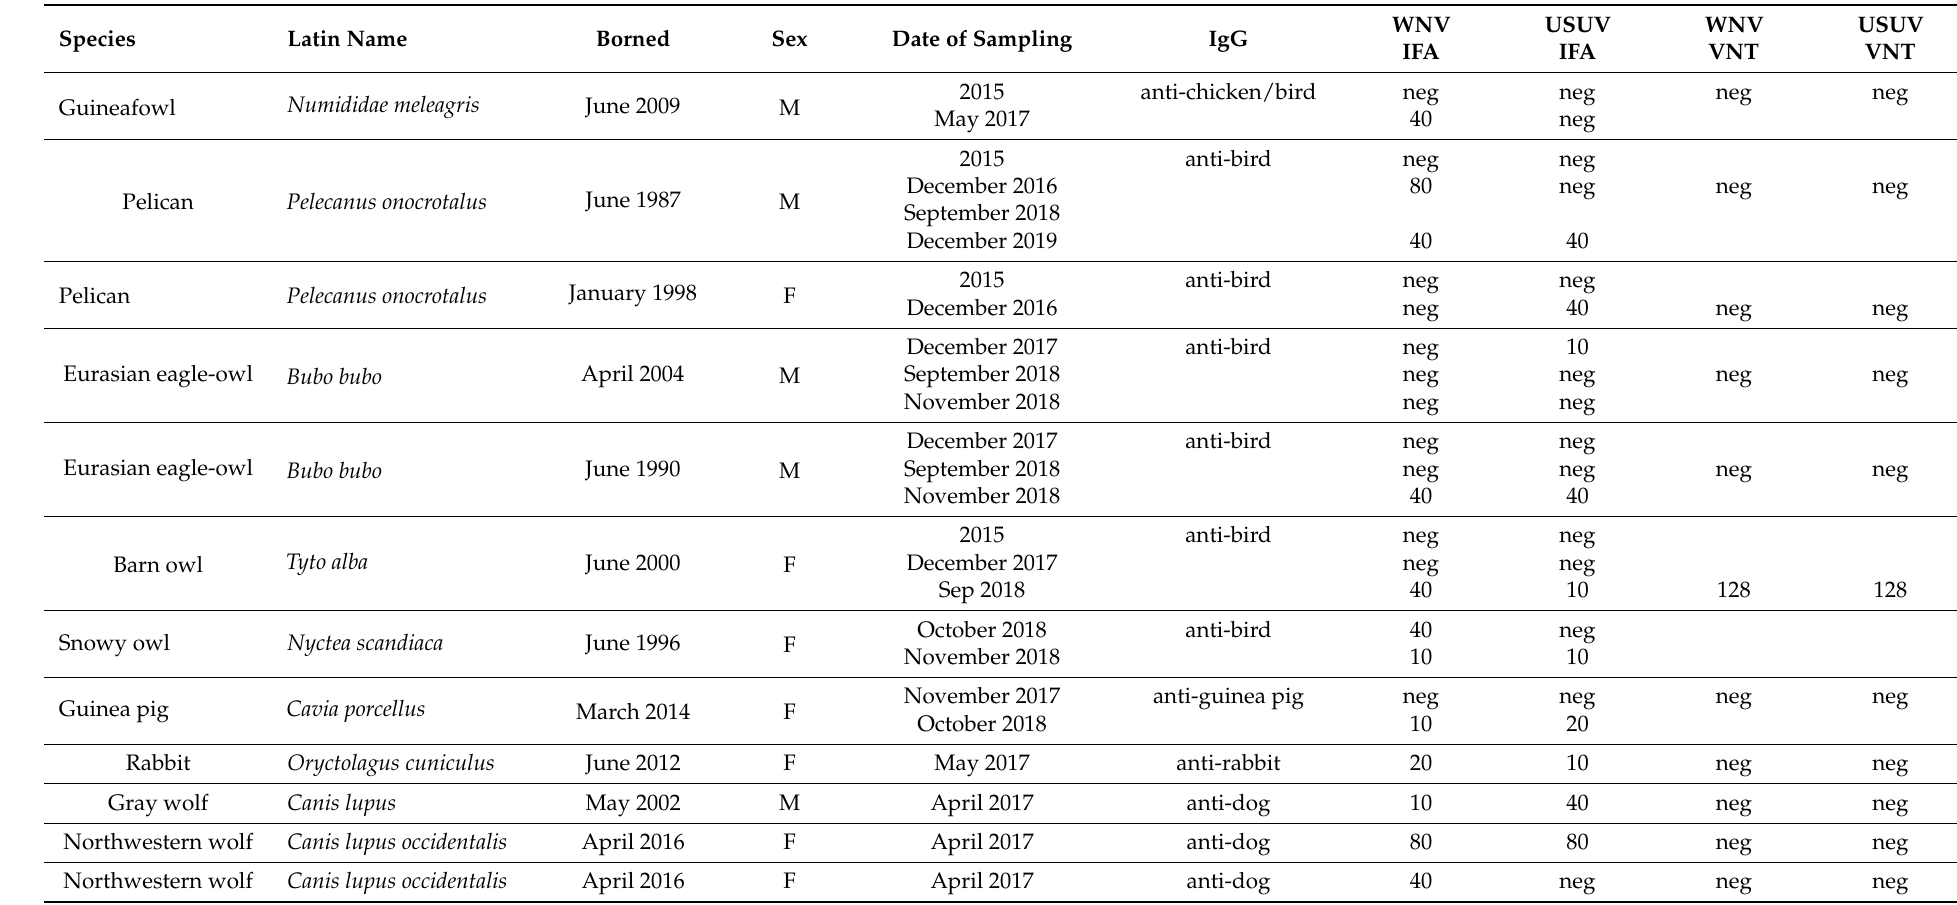
Table 1. Characteristics of zoo animals positive for West Nile virus (WNV) and Usutu virus (USUV) with dynamic of titers in indirect immunofluorescence assay (IFA) and virus neutralization test (VNT) by years of